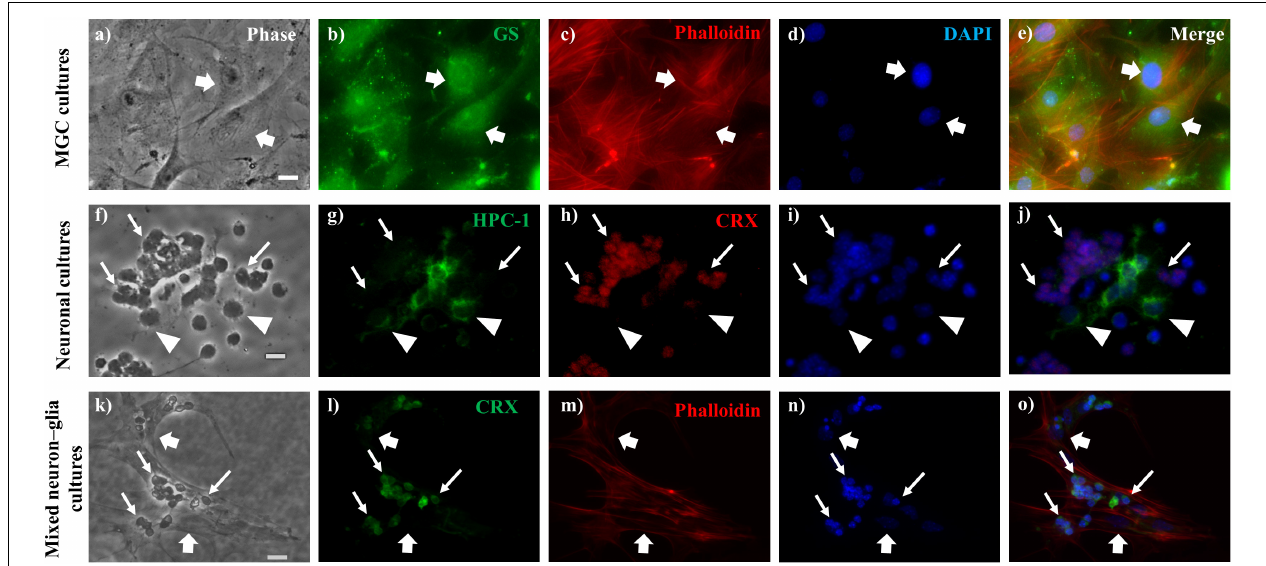
FIGURE 1 | Identification of neurons and Müller glial cells (MGC) in glial, neuronal and mixed neuron-glial cultures. Phase (a,f,k) and fluorescence (b–e,g–j,l–o) photomicrographs of wt MGC culture (a–e) , 2-day wt neuronal cultures (f–j) and 6-day wt mixed neuron-glial cultures (k–o) , showing MGC (thick arrows) identified by their anti-Glutamine Synthase (GS) labeling (b) , with their actin cytoskeleton visualized by phalloidin labeling (c,m) ; photoreceptors (thin arrows) labeled with anti-CRX (h,l) and amacrine neurons (arrowheads) labeled with HPC-1 (g) antibodies. Cell nuclei were visualized with the DNA probe DAPI (d,i,n) . Note that cell nuclei were markedly smaller in neurons than in MGC (n) . Merge images (e,j,o) . Scale bars: 20 µ m.